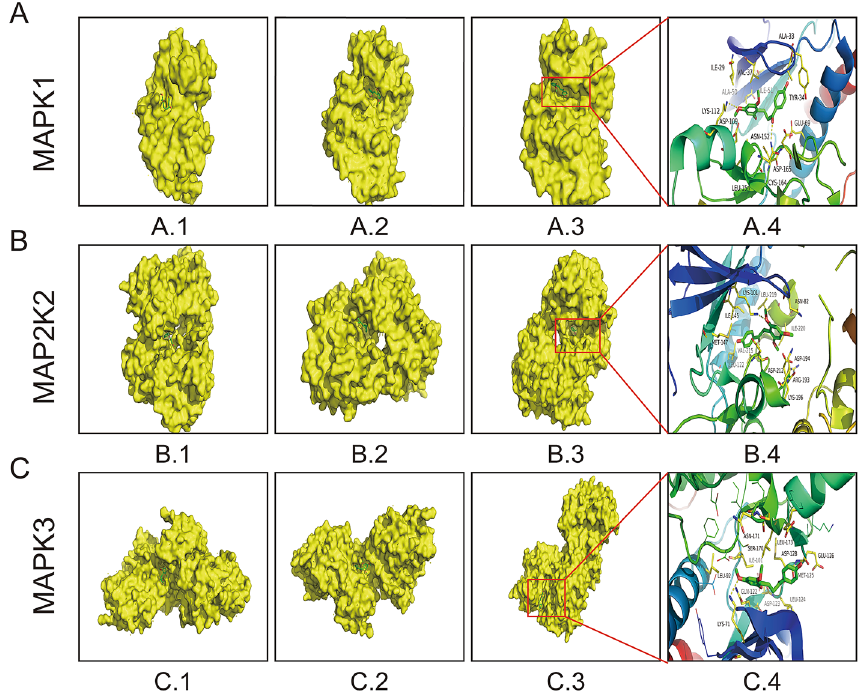
Figure 6. The binding sites of LrB and MAPK1, MAP2K2 and MAPK3. (A.3–C.3) The sites with the highest binding capacity of LrB to MAPK1, MAP2K2 and MAPK3. (A.4–C.4) The molecular structures of the sites with the highest binding capacity of LrB to MAPK1, MAP2K2 and MAPK3.